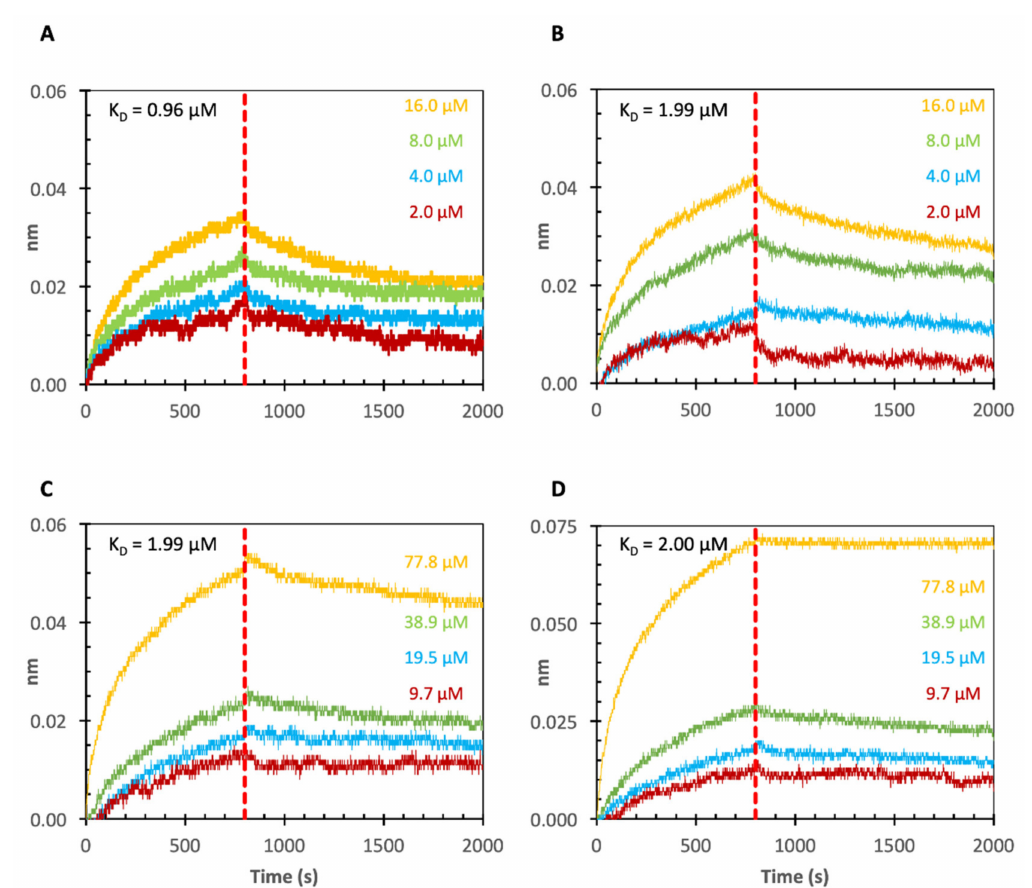
Figure 4. Results of BLI-experiments with Echinacea galactan and commercially purchased Gal-1 ( A ) and Gal-7 ( B ), as well as the corresponding cell-free produced Gal-1 ( C ) and Gal-7 ( D ).